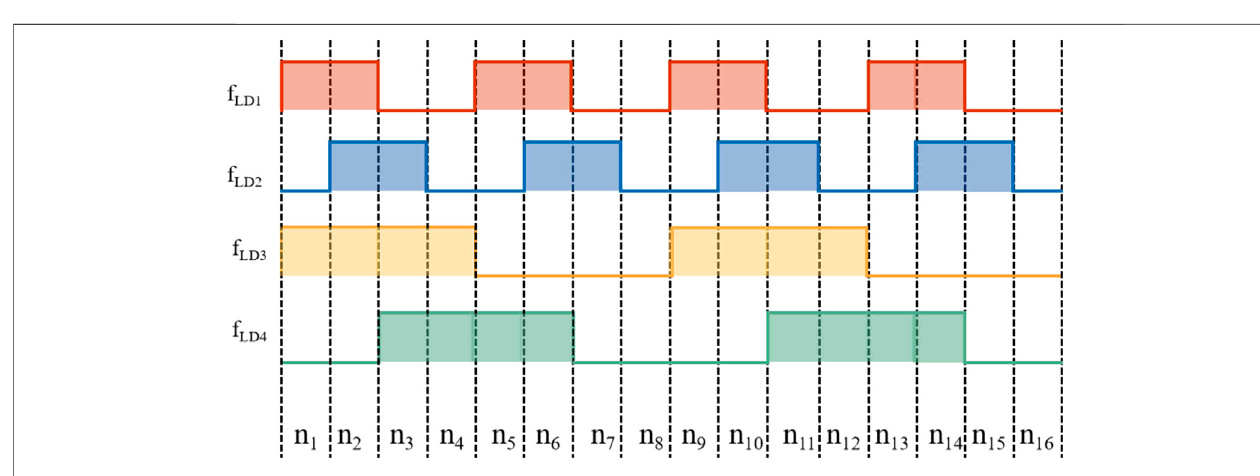
FIGURE 2 | Two sets of double-frequency orthogonal square-wave